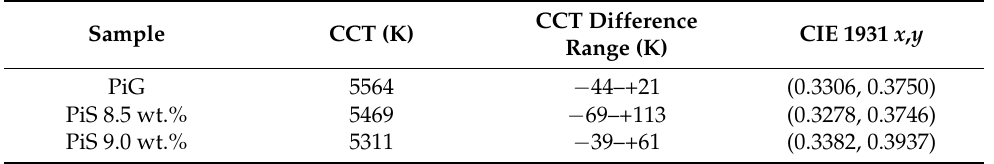
Table 1. Light properties of PiS WLED doped with 8.5 and 9 wt.% YAG phosphors and PiG WLED covered with phosphor